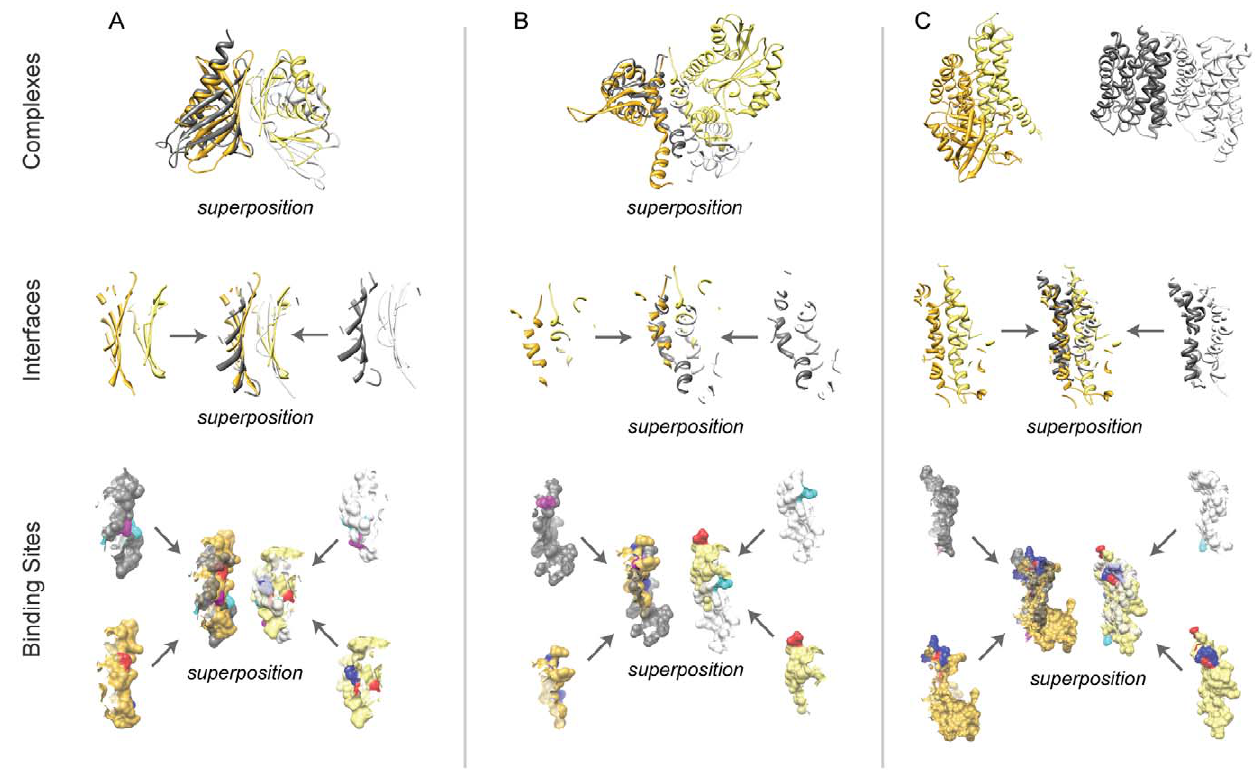
Figure 7. Case studies of similar interactions. (A) H-level interactions ( iiRMSD =2.93 A˚), (B) C-level interactions ( iiRMSD =6.12 A˚), and (C) A-level interactions ( iiRMSD =6.19 A˚). Subunits from the first interaction together with the corresponding interface and binding sites are colored gold and light yellow. Subunits from the second interaction (and their interfaces and binding sites) are colored dark and light grey. Positively and negatively charged residues in the first interaction are colored blue and red, while in the second interaction they are colored cyan and magenta, correspondingly. Superposition refers to the superposed interactions, interfaces, and binding sites.